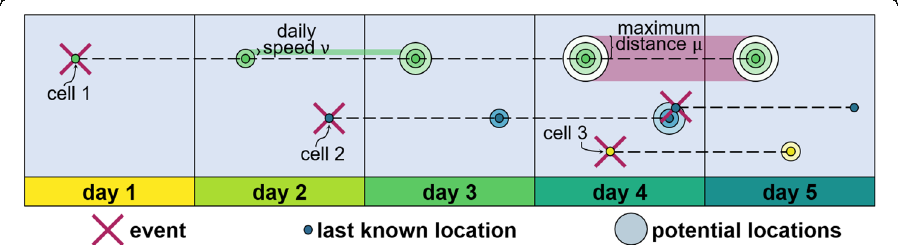
Fig. 1 Schematic representation of the methodology. Events are analysed in sequential order and a unique Boko Haram cell is assigned to each one. For each event, the algorithm decides if an existing cell is involved in the attack or if a new (or not previously identified cell) is responsible. In the figure, an event took place during the first day, which means that a cell is created. The location of that event is its last known location and the date of the event is its last known date. The potential location of that cell increases each day according to its daily speed, . After a few days (four in the example) a cell has reached the maximum distance between consecutive events and so it is assumed that it remains within that region (in the example, μ = 4 ν ). Then, during days 2 and 4, there is no cell nearby who could have been involved in the new events and so new cells are identified. During day 4, there is an event for which an existing cell is potentially responsible, so its last known location and date are